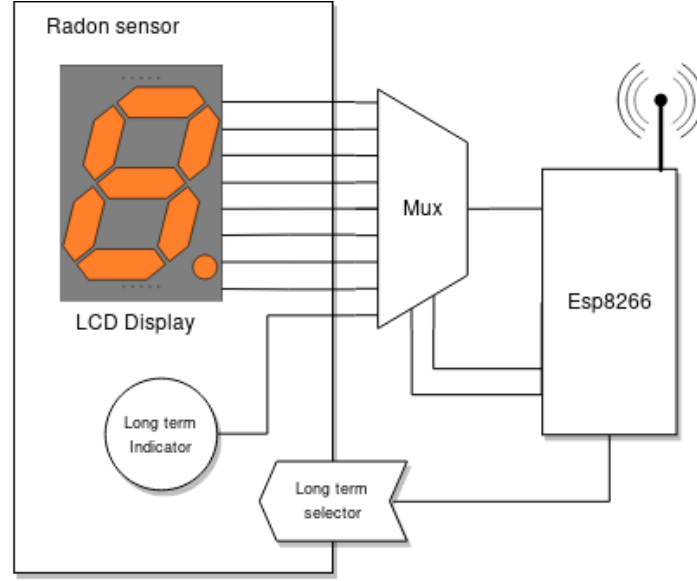
Figure 4. Interface with the sensor used to obtain the